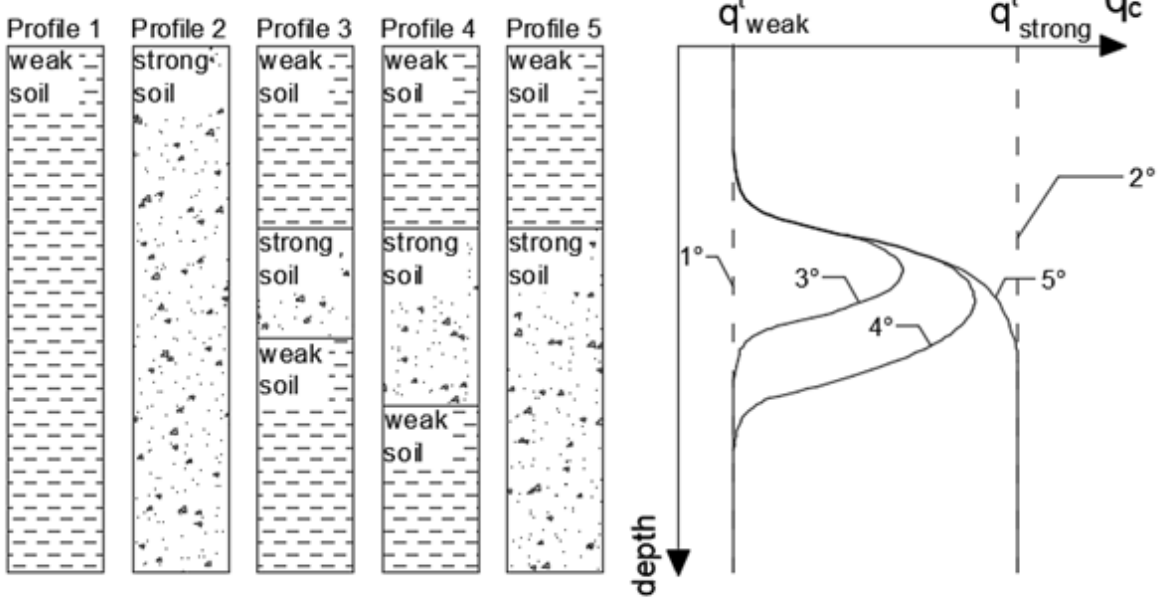
Figure 5: The schema of the effect of thin layer and transition zone